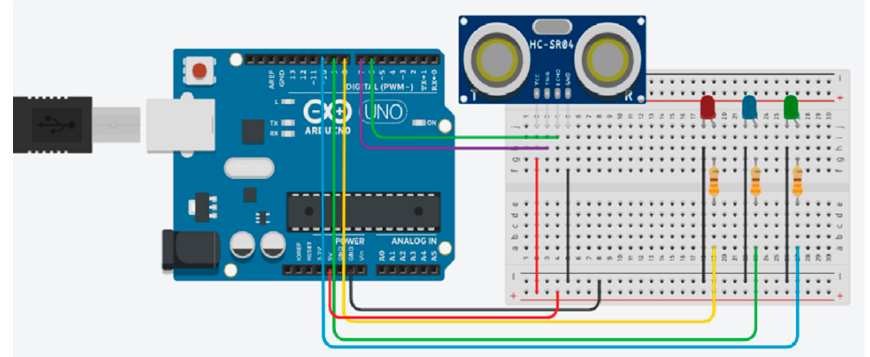
Figure A1. Distance-Sensitive bracelet model’s circuit.